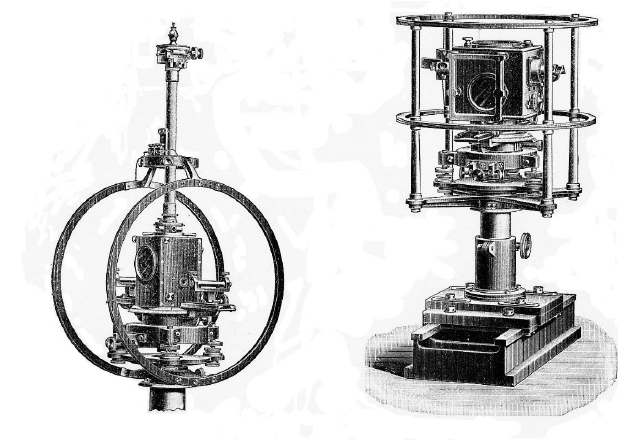
Figure 7. Upper part of the horizontal magnetometer (left) and the vertical one (right). Source: Schmidt